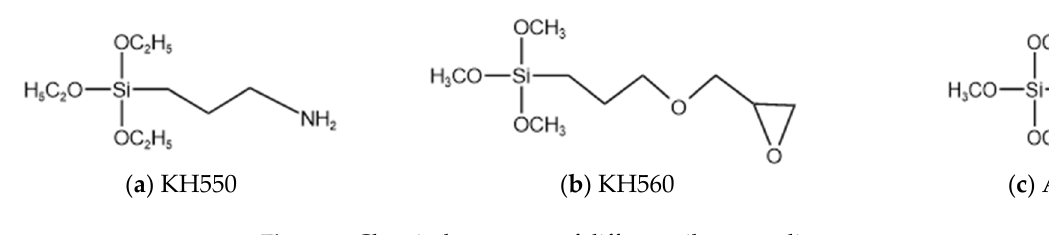
Figure 1. The preparation process of BFRPs.